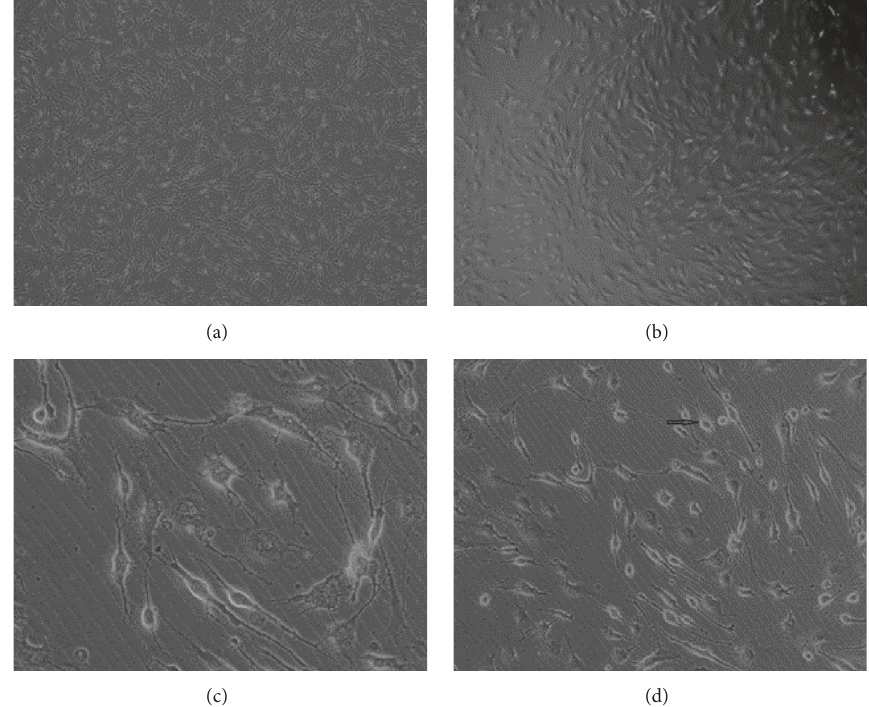
Figure 1: Images showing that different concentrations of resveratrol (0.0 mg/L (a), 7.5 ml/L (b), 15.0 mg/L (c), and 30.0 mg/L (d)) induce differentiation of hUC-MSCs into neuron-like